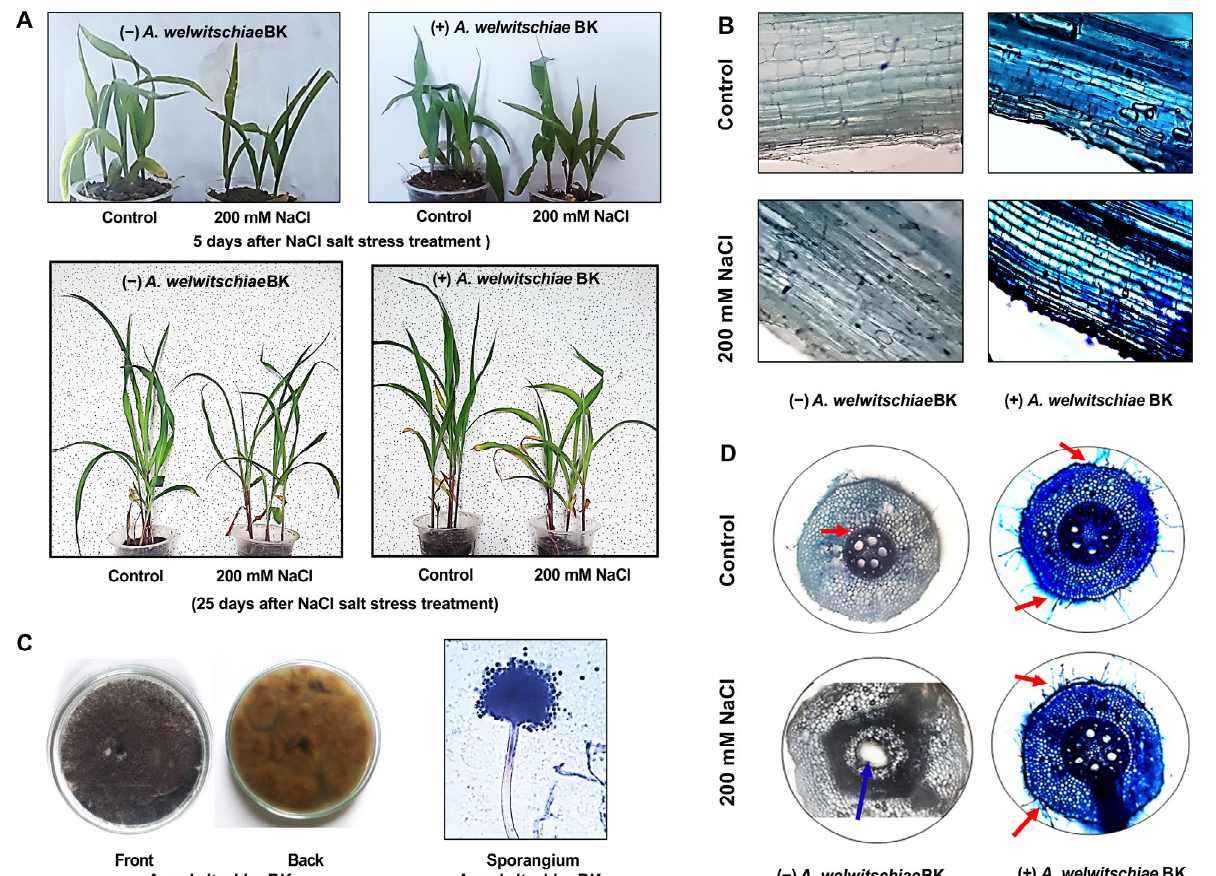
Figure 1. ( A ) Maize plant growth under control and salt stress conditions, both with A. welwitschiae BK supplementation. ( B ) Maize root transverse section showing endophytic colonization by A. welwitschiae BK, grown under salt stress conditions (200 mM NaCl) and normal conditions compared with the non-inoculated control. ( C ) Colony morphology of A. welwitschiae BK on PDA medium, front view (left penal), back view (middle penal), and sporangium morphology (right penal). ( D ) Maize root cross section showing the e ff ect of A. welwitschiae BK on lysogenic aerenchyma production in maize roots under salt stress. Red arrows indicate colonization and the blue arrow indicates lysogenic aerenchyma spaces.